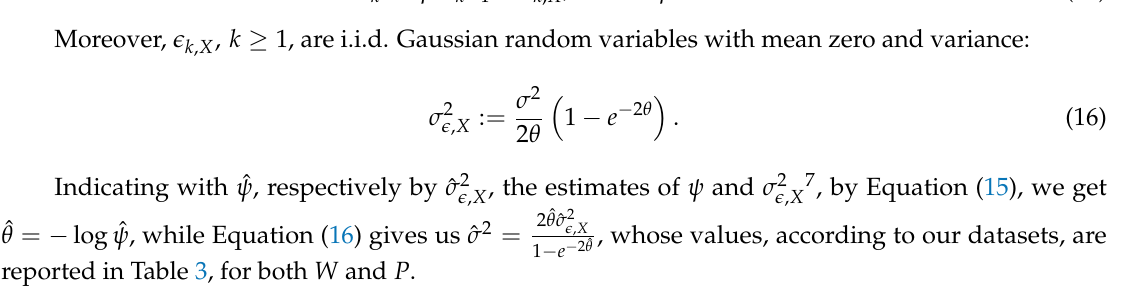
Table 3. Estimated parameters from the calibration of the wind speed and wind power production time